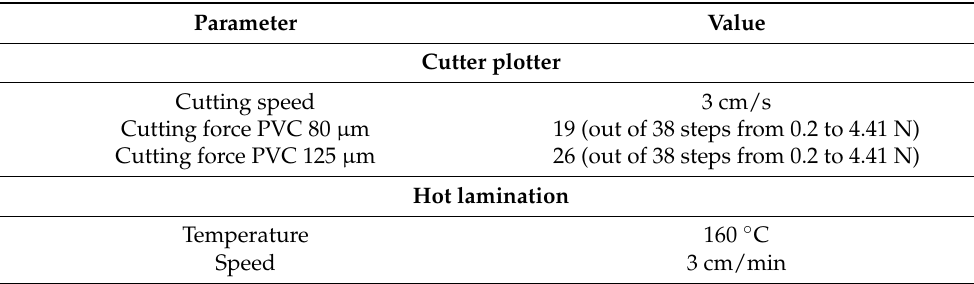
Table 1. Operating parameters of cutter plotter and hot